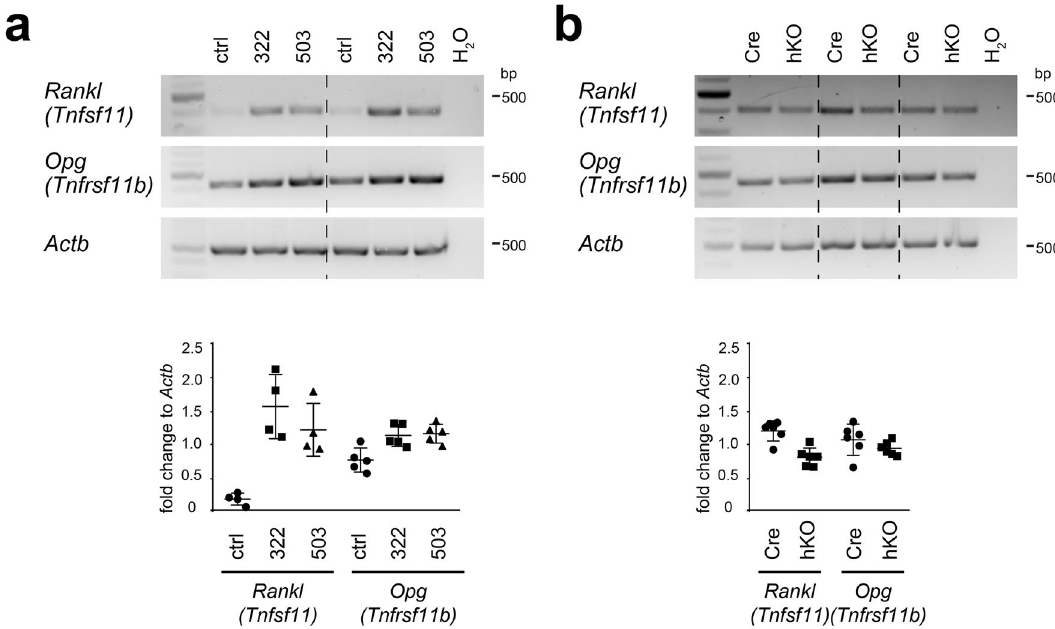
Figure 5. Determination of Rankl and Opg gene expression in miRNA mimic-transfected chondrocytes and in cultured chondrocytes from Mirc24 cluster-deficient mice. The gene expression of Rankl and Opg was analyzed by semi-quantitative PCR ( a ) in control (ctrl), miR-322 (322) or miR-503 (503) mimic-transfected primary epiphyseal chondrocytes (PECs) 2 days post transfection and ( b ) in PECs isolated from newborn male Col2a1- Cre (Cre) and Col2a1-Cre- Mirc24 tm1M/Y (hKO) mice and cultured for 2 days. The control (H 2 O) contains no genomic DNA and Actb served as loading control. Rankl or Opg to Actb ratio was determined by ImageJ and individual and mean values and standard deviations are shown (graph). The size of NEB Quick-Load Purple 1 kb Plus DNA Ladder bands is shown. The figure was created using Adobe Illustrator CS6 (Version 16.0.3, https:// adobe. com/ produ cts/ illus